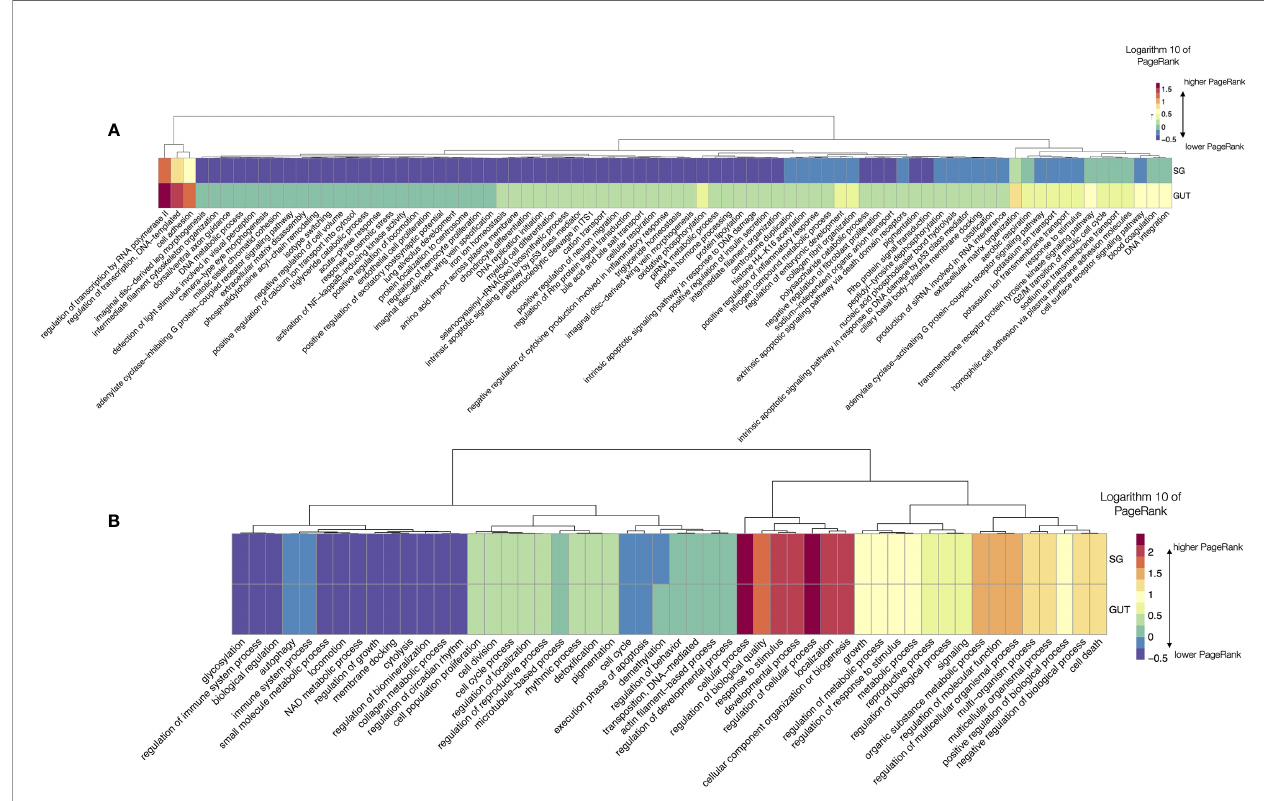
FIGURE 7 | (A) A heatmap displaying the values of the log10 of PageRank of the low-level processes in salivary glands (SG) and gut of O. rostratus . The chart displays only the processes with a rate of change between organs located in the top percentile 99% of variability (i.e., only the 1% of processes, those with highest variability, are shown). The heatmap shows the processes grouped according to a dendrogram (top) grouping those processes with similar patterns of variability. Dots show breaking points of the dendrogram, intended only as a help for interpretation. (B) A heatmap displaying the values of the log10 of PageRank of the top- level processes in salivary glands (SG) and gut of O. rostratus